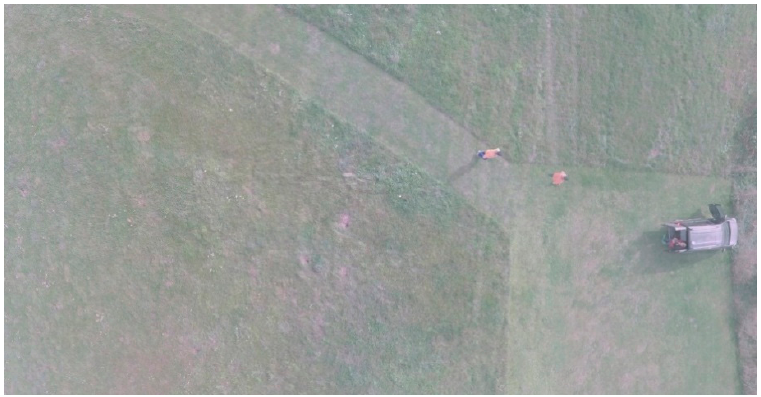
Figure 11. The final mosaicking result from five cameras.